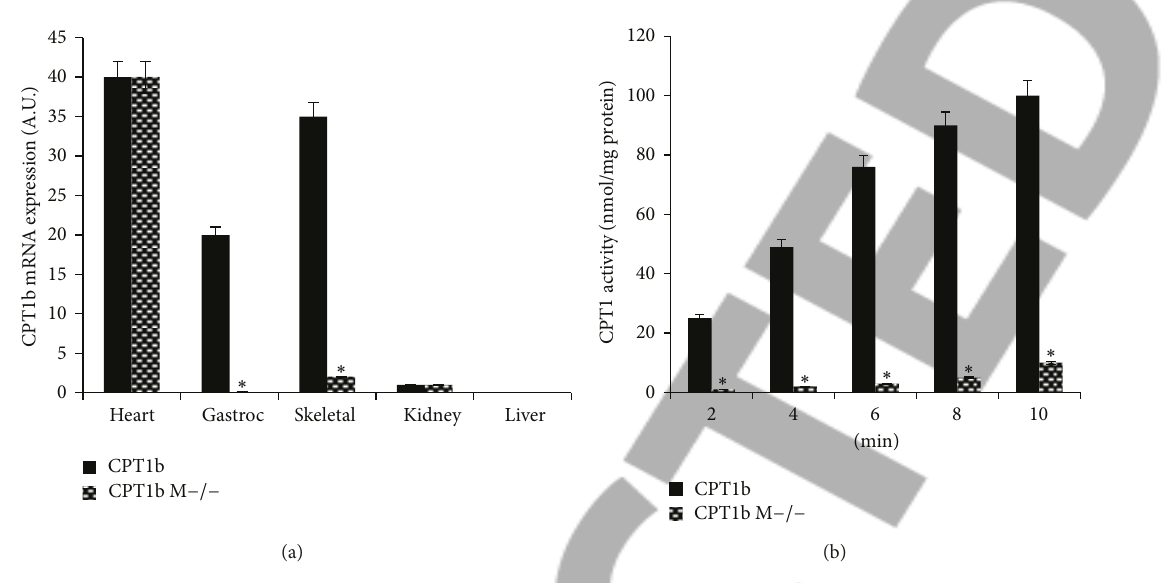
Figure 1: (a) CPT mRNA expression in different tissues, compared between wild type with CPT1b and knockout mice with CPT1b M − / − . It showed that the expression of CPT1b was significantly reduced in gastric and skeletal muscles ( ∗ 𝑃 < 0.05 ). (b) CPT1 activities were reduced in knockout mice compared with wild type, significant at 2, 4, 6, 8, and 10 minutes ( ∗ 𝑃 < 0.05 ). 𝑛 = 20 for each group. Table 1: General and metabolic profiles at 30 weeks of